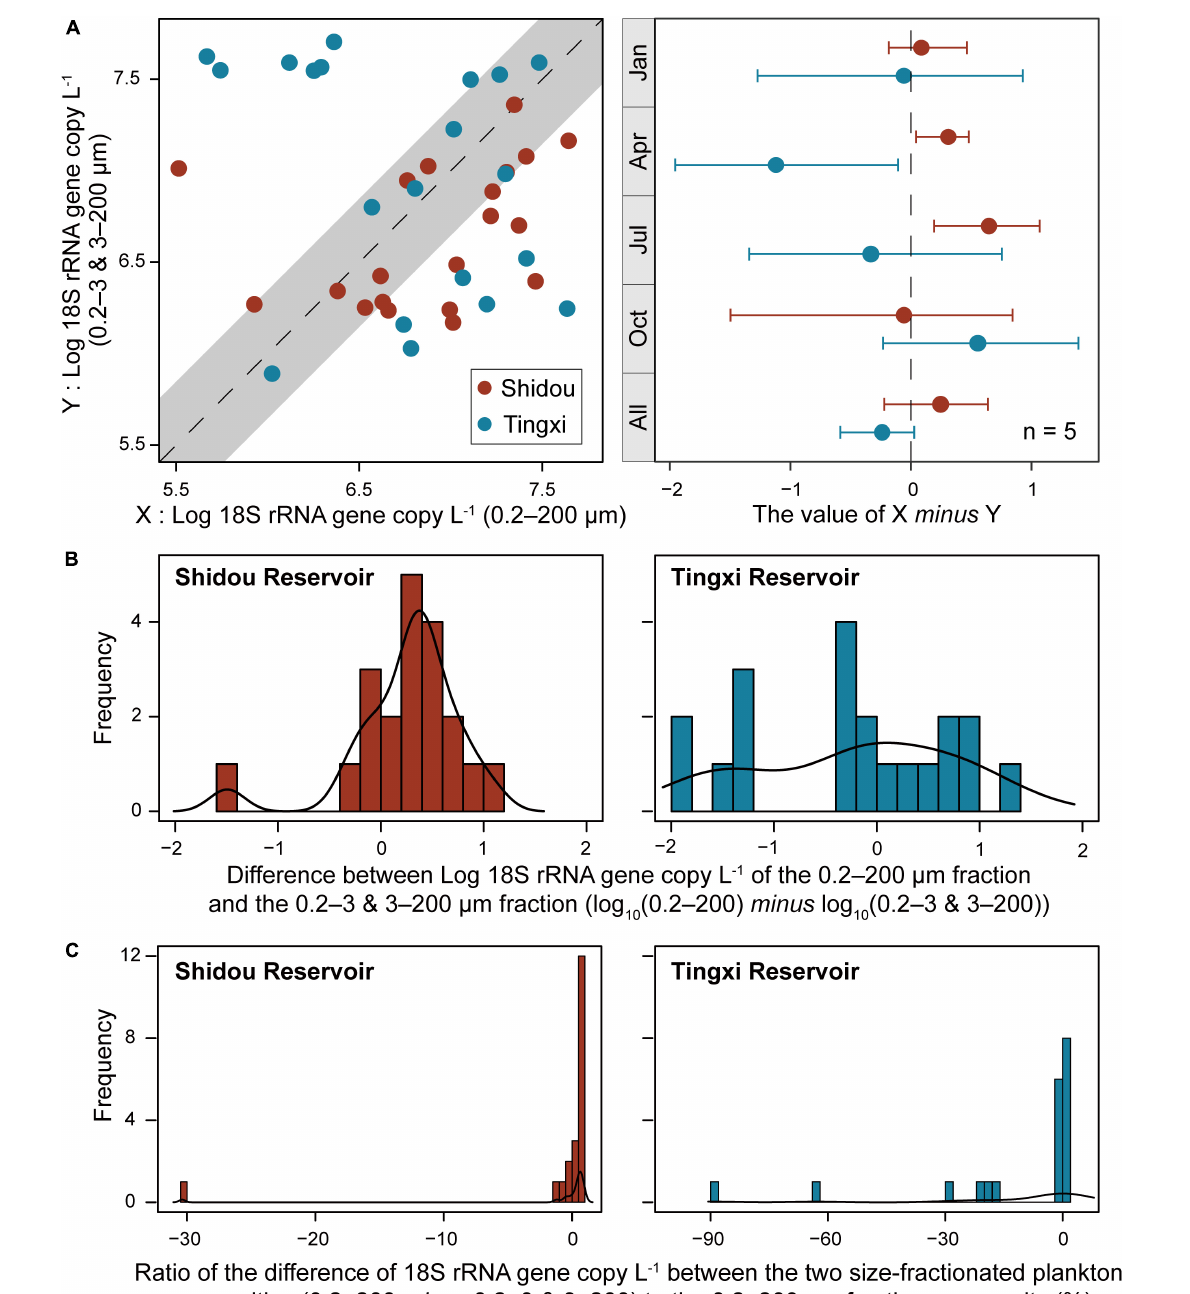
FIGURE4 Comparison of the 18S rRNA gene abundance between the two size-fractionated plankton communities (with 95% confidence interval) and their seasonal difference (the error bar represents the standard error along with five water layers, n = 5) (A) . Histogram showing the distribution frequency of log10 18S rRNA gene copy of the 0.2–200 µ m minus 0.2–3 and 3–200 µ m size fractions (B) , and the ratio of the difference to 0.2–200 µ m fraction (C) . The difference of 18S rRNA gene abundance between the two size-fractionated plankton communities was less than 50% of the 0.2–200 µ m microbial eukaryotic community for 95% of the total